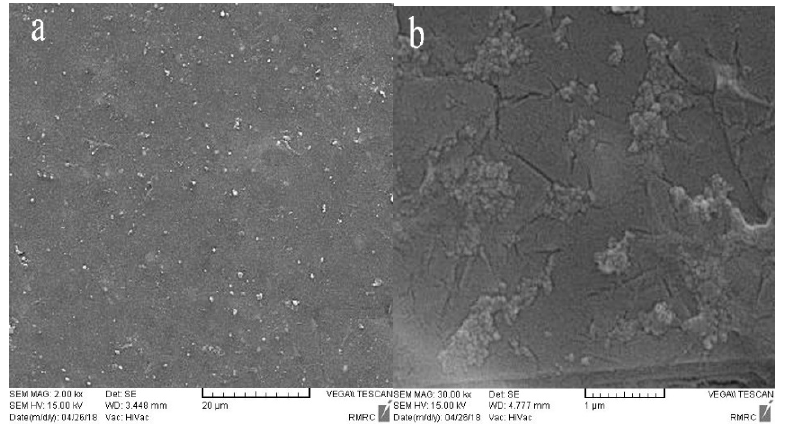
Figure 9. SEM analysis results of E. coli reproduction on ( a ) PSF and ( b ) GO-Pt (0.75 wt%) membranes surfaces.